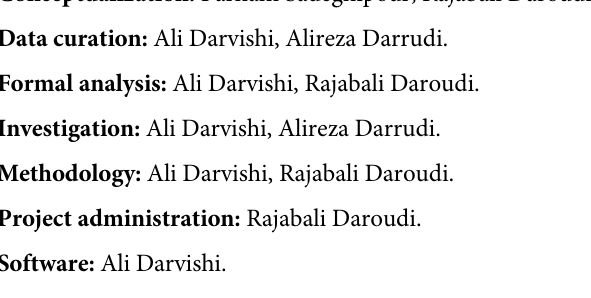
S1 Table. Probability of death at different ages (Iran Life